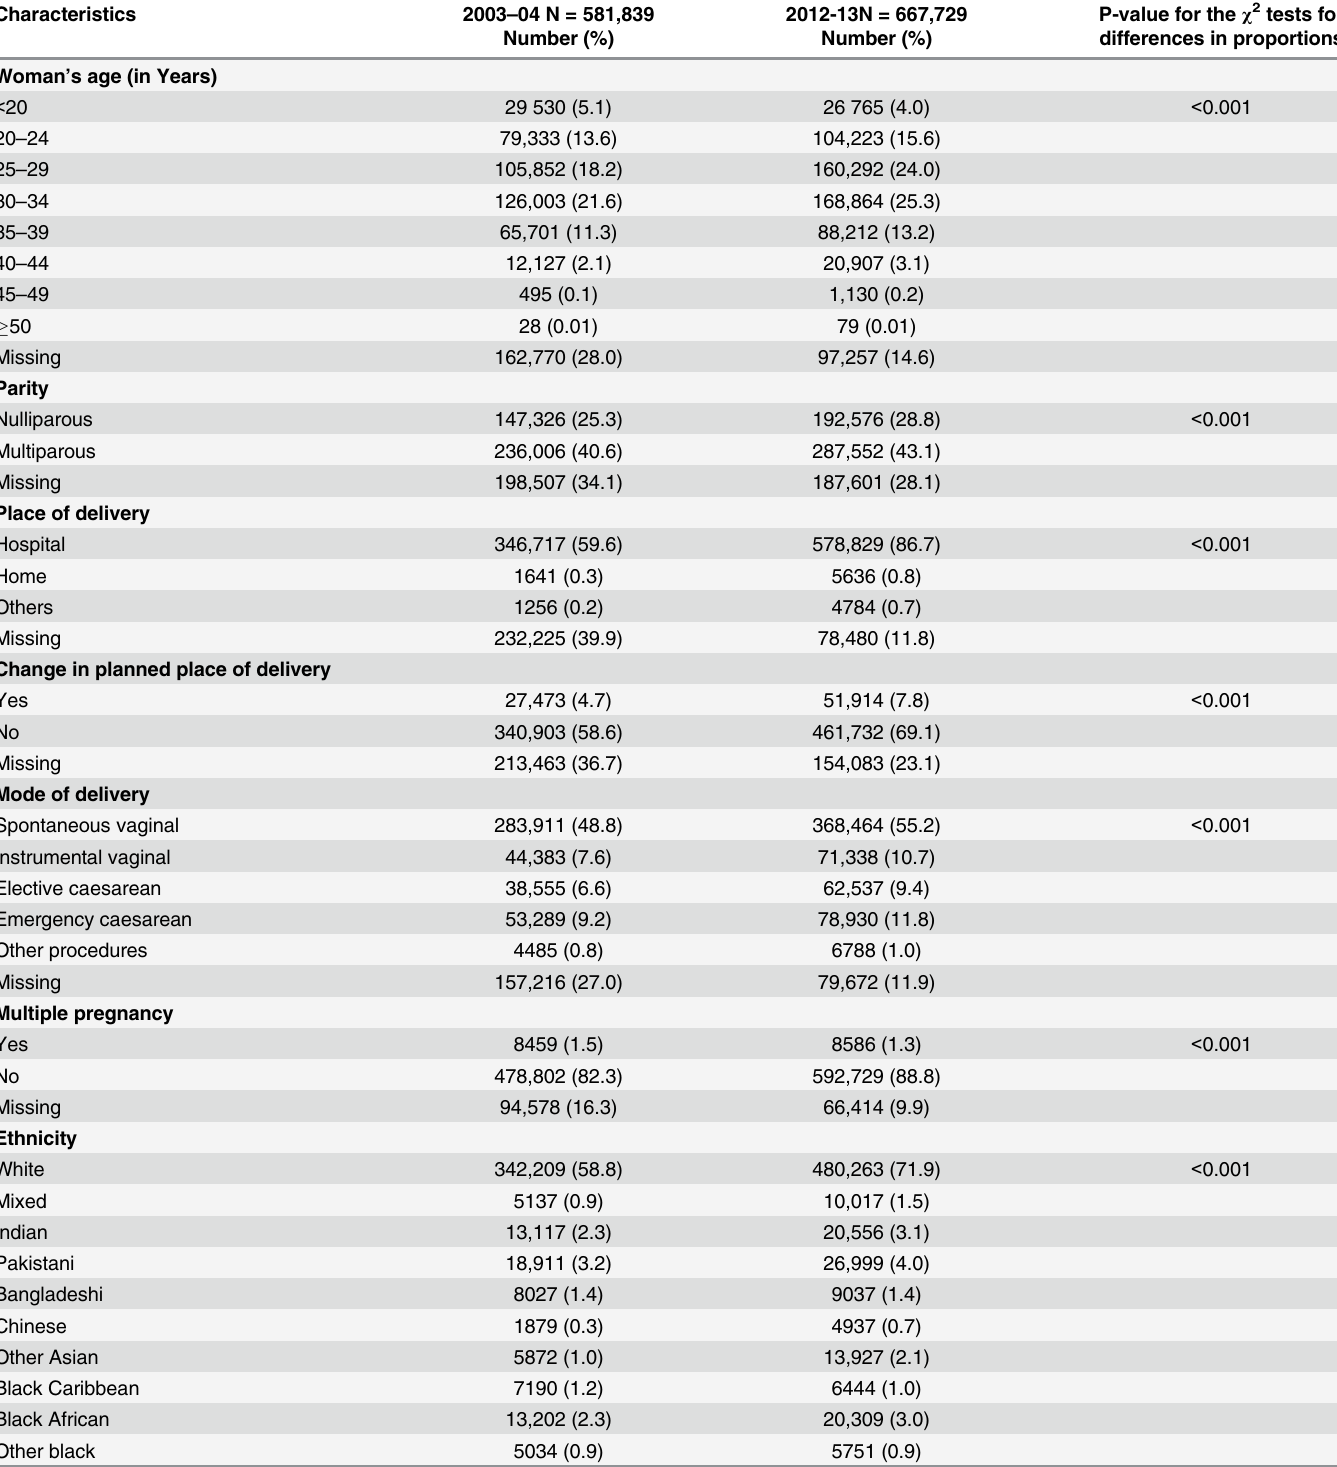
Table 1. Change in maternal and pregnancy characteristics in England in 2012 – 13 compared to 2003 – 04; Hospital Episode Statistics data England.